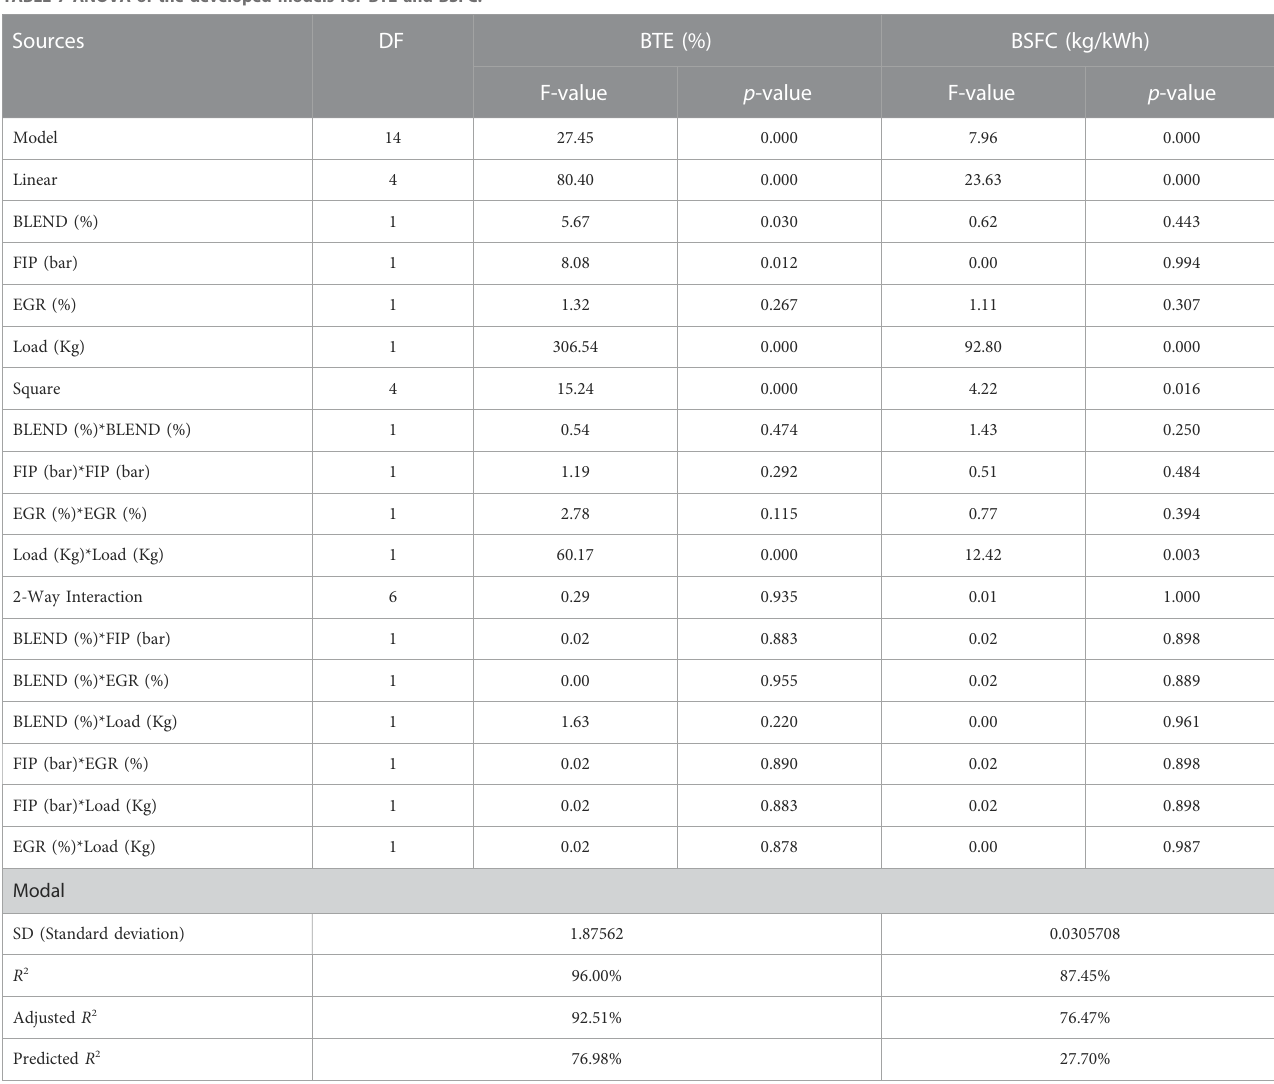
TABLE 7 ANOVA of the developed models for BTE and BSFC.